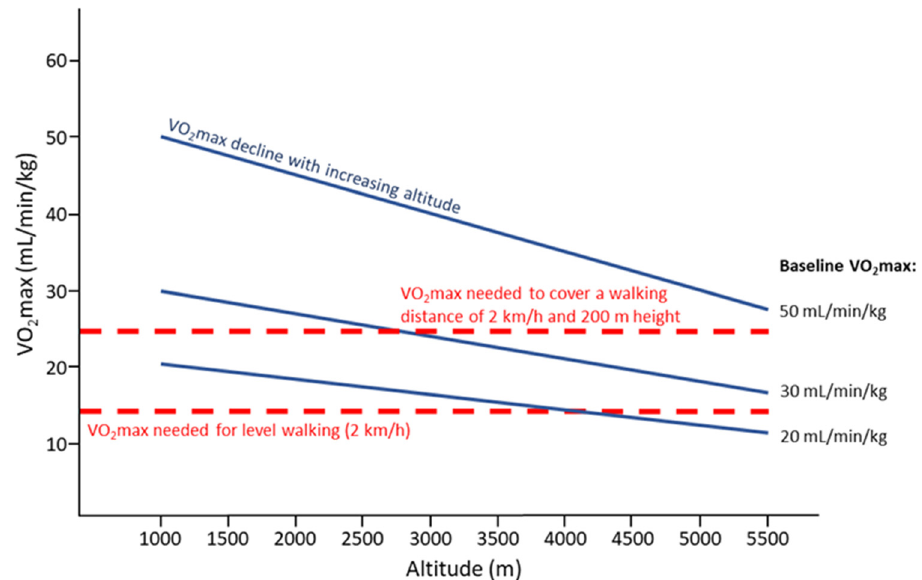
Figure 2. Decline of VO 2 max with increasing altitude (solid lines) depending on the baseline VO 2 max (50, 30, and 20 mL/min/kg), and VO 2 max needed for level walking at a pace of 2 km/h or covering 2 km/h on a slope with a 200 m difference in altitude (dashed lines); based on calculations provided in [88]. It is assumed that people will walk at 60% of their individual VO 2 max.